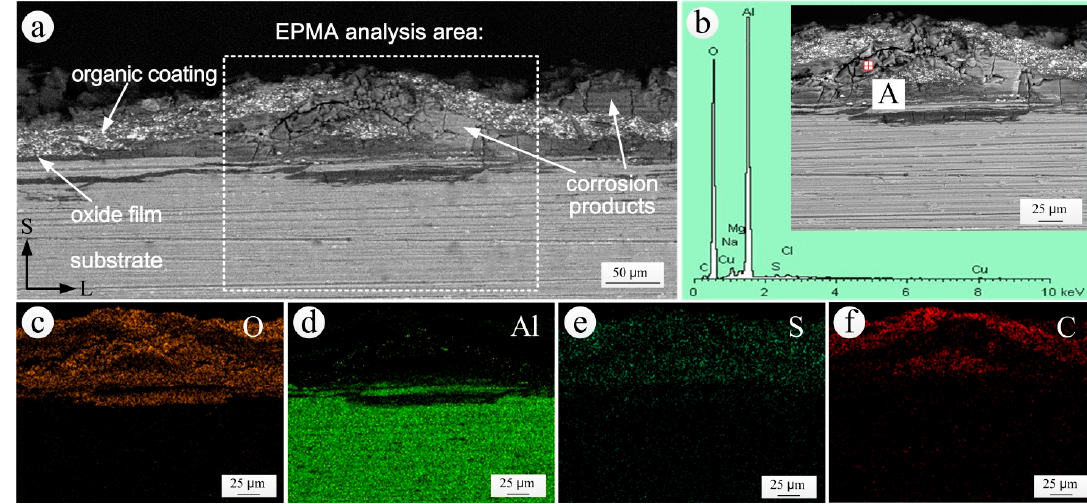
Figure 11. S-L sectional analysis in the coating bubbling area of coated specimen exposed for 20 years: ( a ) SEM morphology; ( b ) EDS spectrum of the corrosion products; ( c – f ) the elemental distributions of O, Al, S and C obtained by EPMA.